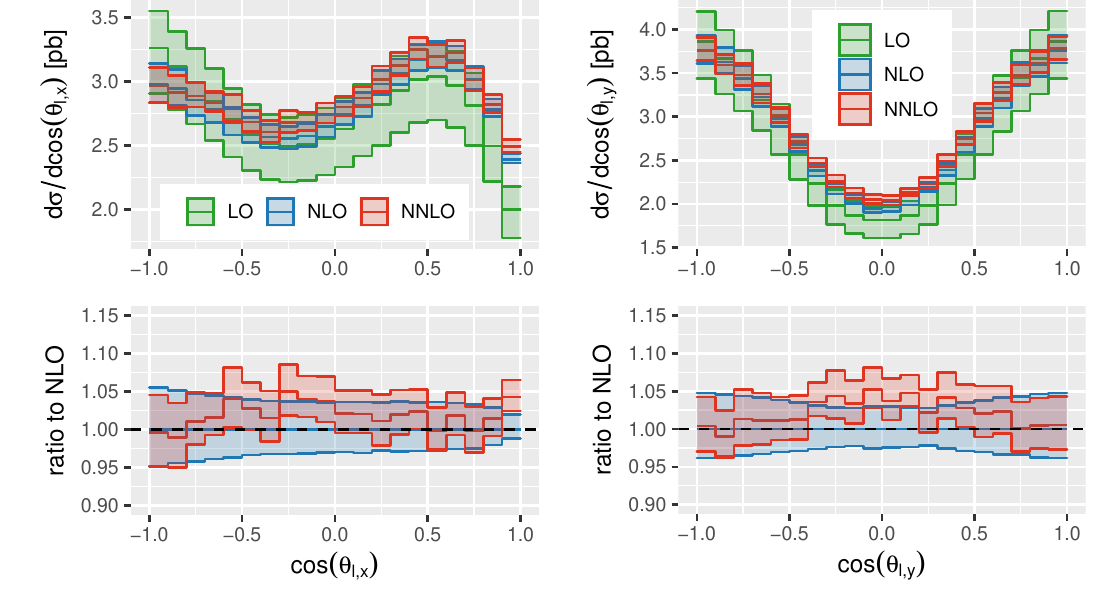
Figure 19 . Angular distributions for cos θ l,x (left) and cos θ l,y (right).